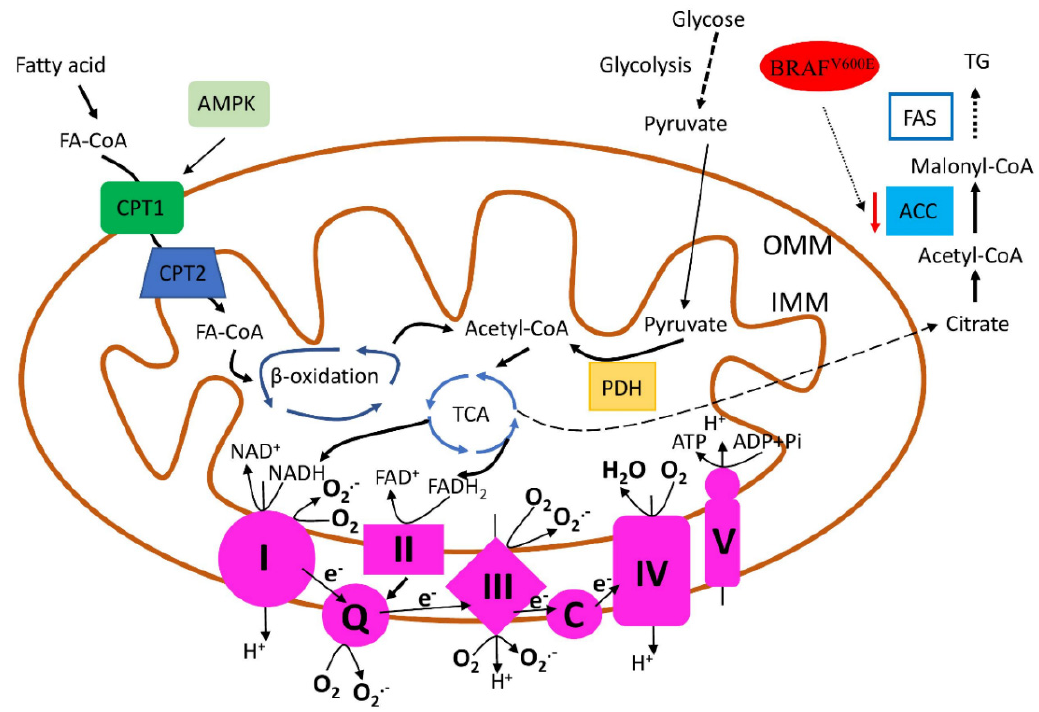
Figure 1. Mitochondrial FAO, ETC. Mutations in mtDNA lead to dysregulation in mitochondrial FAO, ETC, resulting in decreased ATP synthesis and increased ROS production. Effective energy generation (metabolised FA, supplied via FAO and TAC to ETC to produce ATP) is required for tumours’ development and progression. Regulation of the key FAO- ( CPT1 and ACC1 ) and ETC- related genes ( NOX4 and COX4 ) have been suggested as a promising strategy to decrease the efficacy of mitochondrial respiration of cancer cells. FAS—fatty acid synthesis; TG—triglyceride; PDH—pyruvate dehydrogenase; TCA—tricarboxylic acid cycle; I–V—components of mitochon- drial ETC (respiratory) chain; Q—ubiquinone, coenzyme Q; C—cytochrome c.